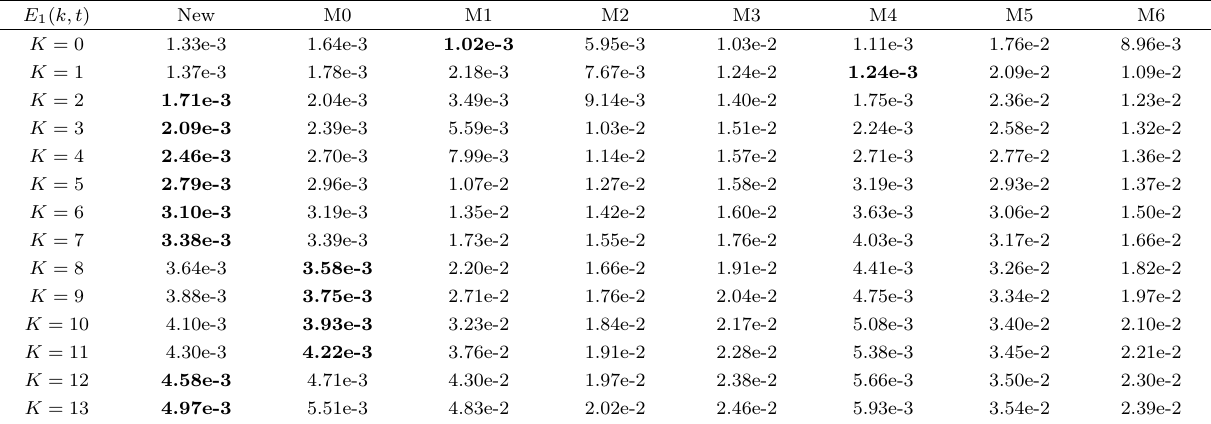
Table 1 Maximum errors of E 1 ( k,t ) for λ = 0 . 15